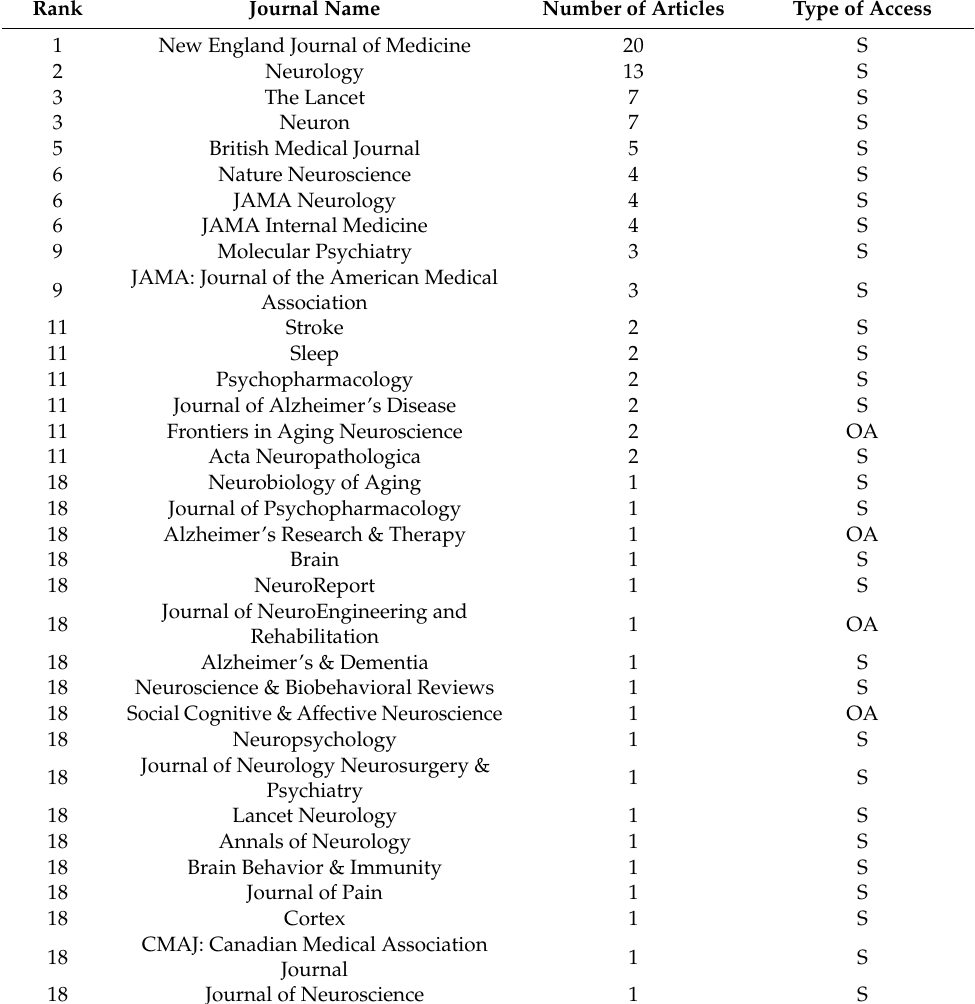
Table 2. Journals with top 100 articles, ranked according to the AAS.